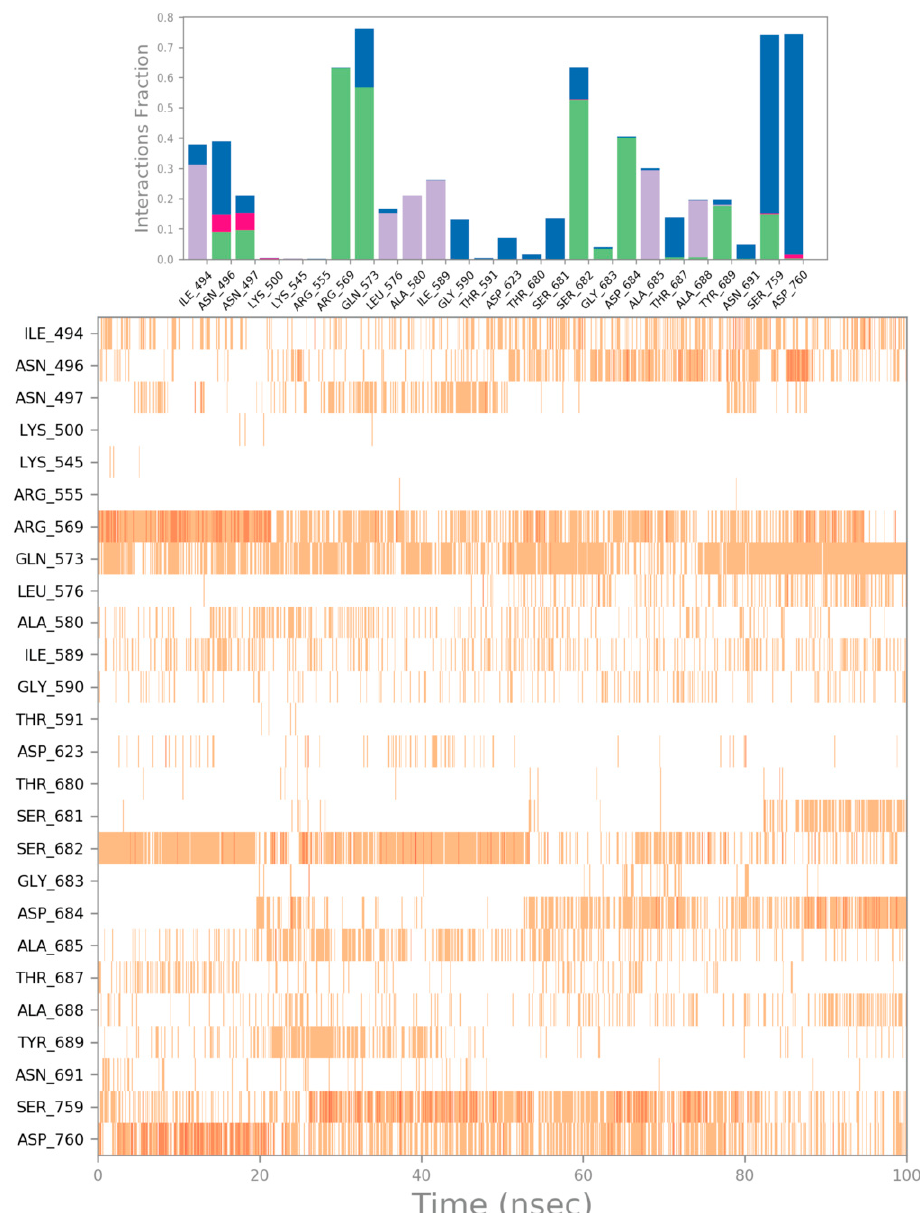
Figure 6. Compound 3 monitored during the simulation. The contacts can be grouped by type and summarized, as shown in the plots. Grouping protein–ligand interactions into four types: H-bonds (green), hydrophobic (grey), ionic (magenta), and water bridges (blue). The second graph of the picture displays a timeline representation of the contacts. Some residues make more than one specific contact with the ligand, which is represented by a darker shade of orange.